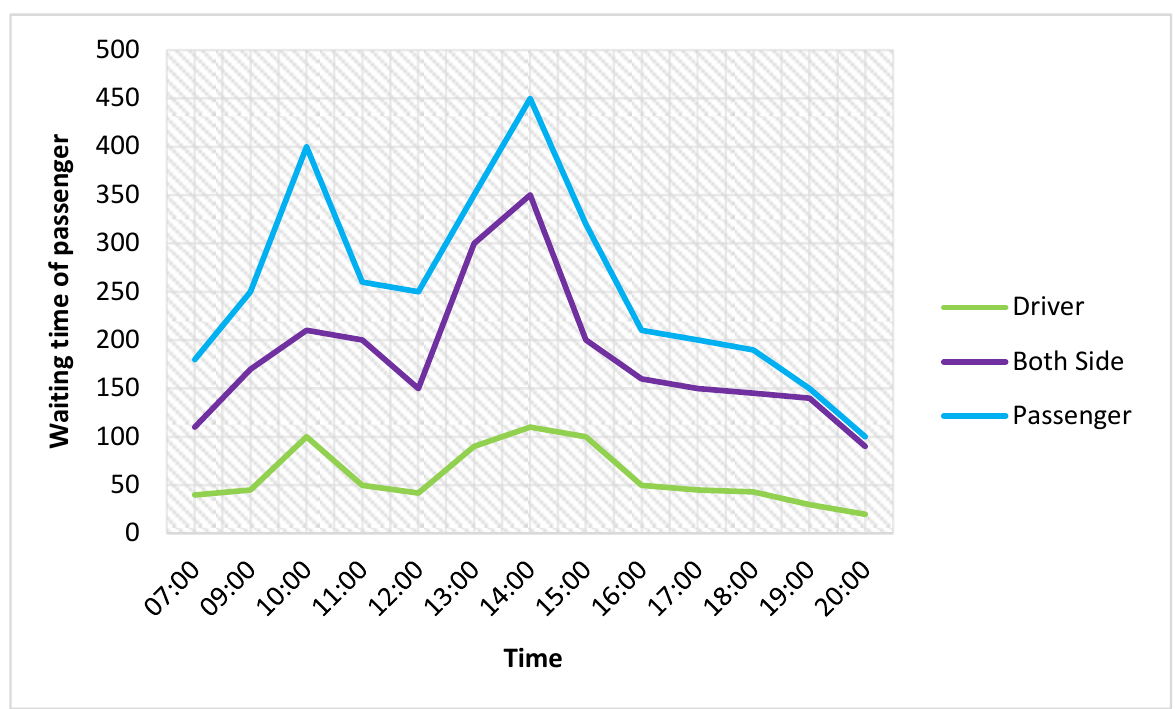
Figure 17. Passenger saved waiting